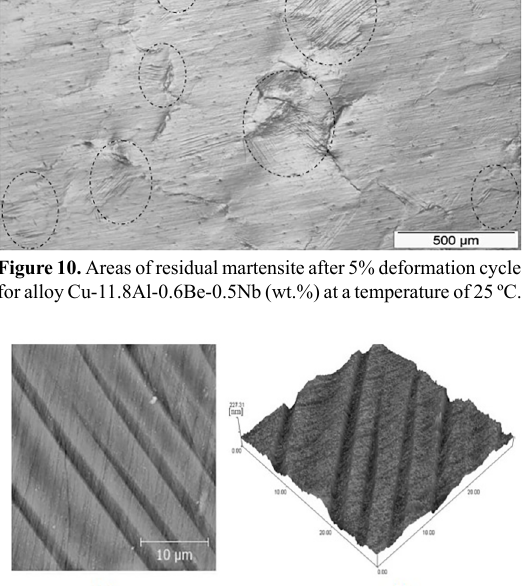
Figure 9. Residual strain as a function of the number of cycles for alloy Cu-11.8Al-0.6Be-4Nb (wt.%) at a temperature of 25 ºC.